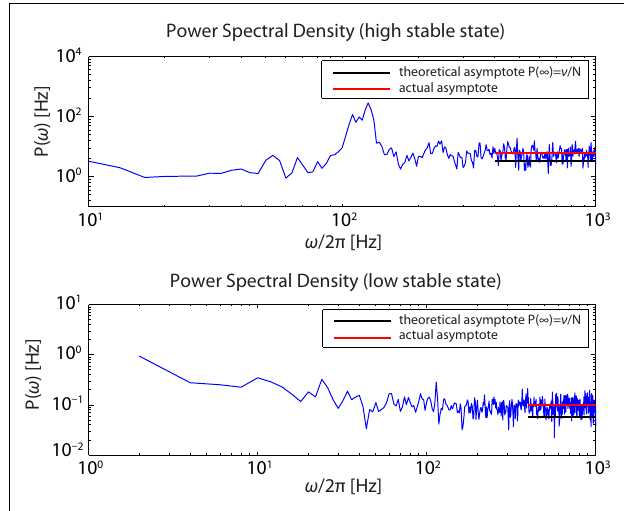
FIGURE 7 | Power spectra of the firing activity of population E att in the “high” (upper panel) and the “low” (lower panel) stable states.